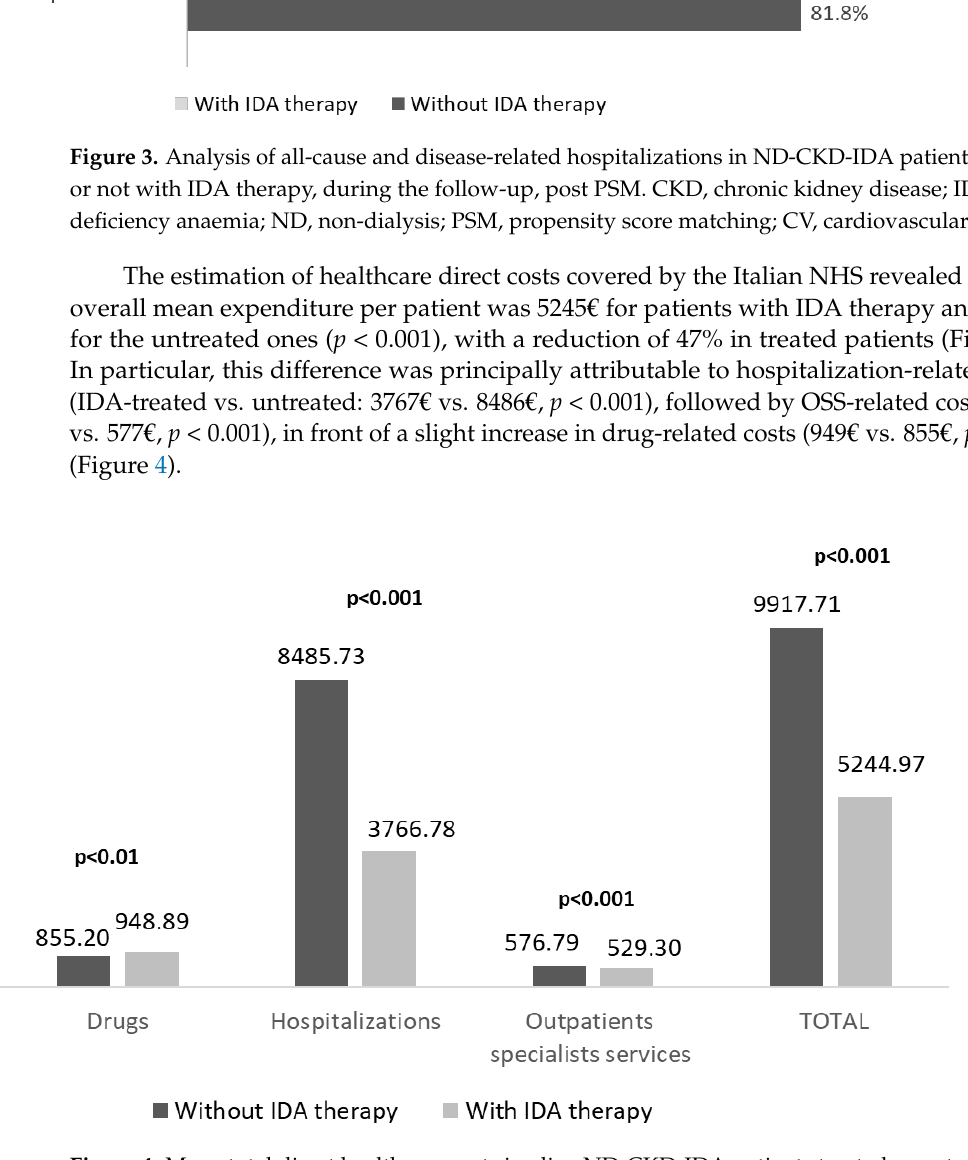
Figure 4. Mean total direct healthcare costs in alive ND-CKD-IDA patients treated or not with IDA therapy, during the follow-up, post PSM. CKD, chronic kidney disease; IDA, iron-deficiency anaemia; ND, non-dialysis; PSM, propensity score matching.